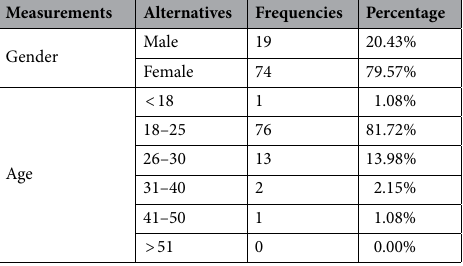
Table 4. Basic information for the respondents of the pilot questionnaire